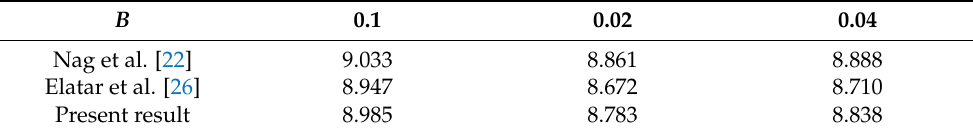
Figure 2. Grid measurement for various elements. Table 2. Global Nusselt number on cool wall for Ra = 10 6 and L = 0.20.